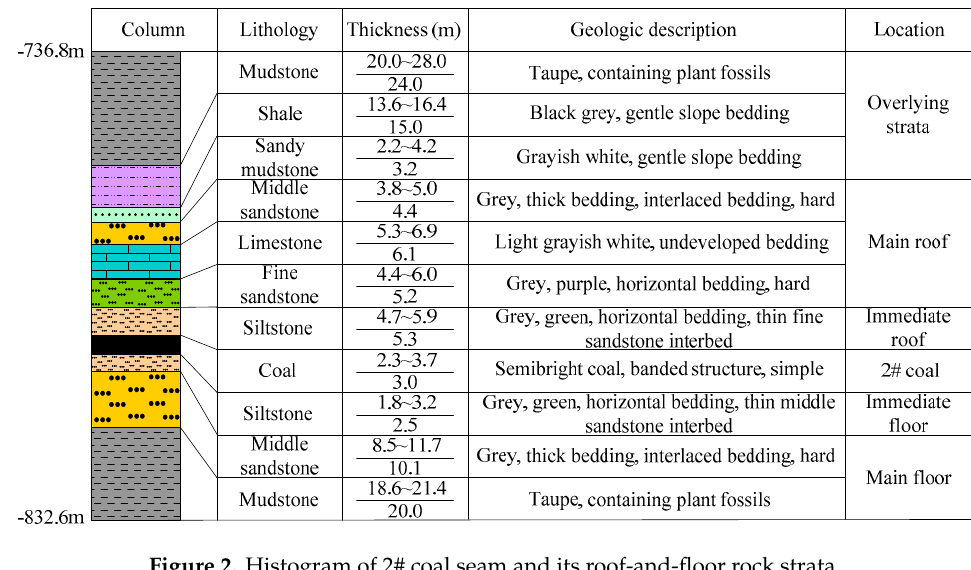
Figure 2. Histogram of 2# coal seam and its roof-and-floor rock strata.